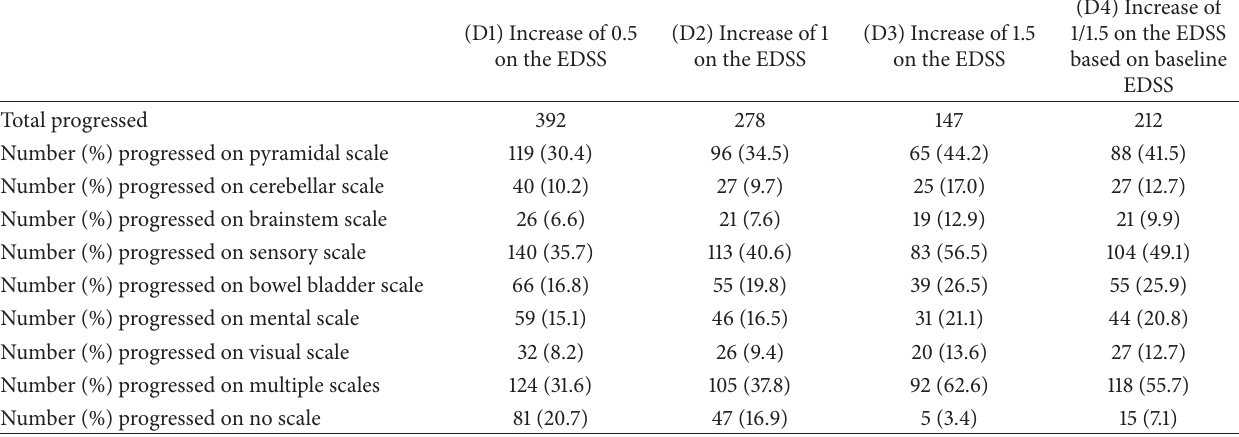
Table 3: Proportion of patients who experienced sustained increases in functional systems associated with sustained progression on the EDSS. (D1) Increase of